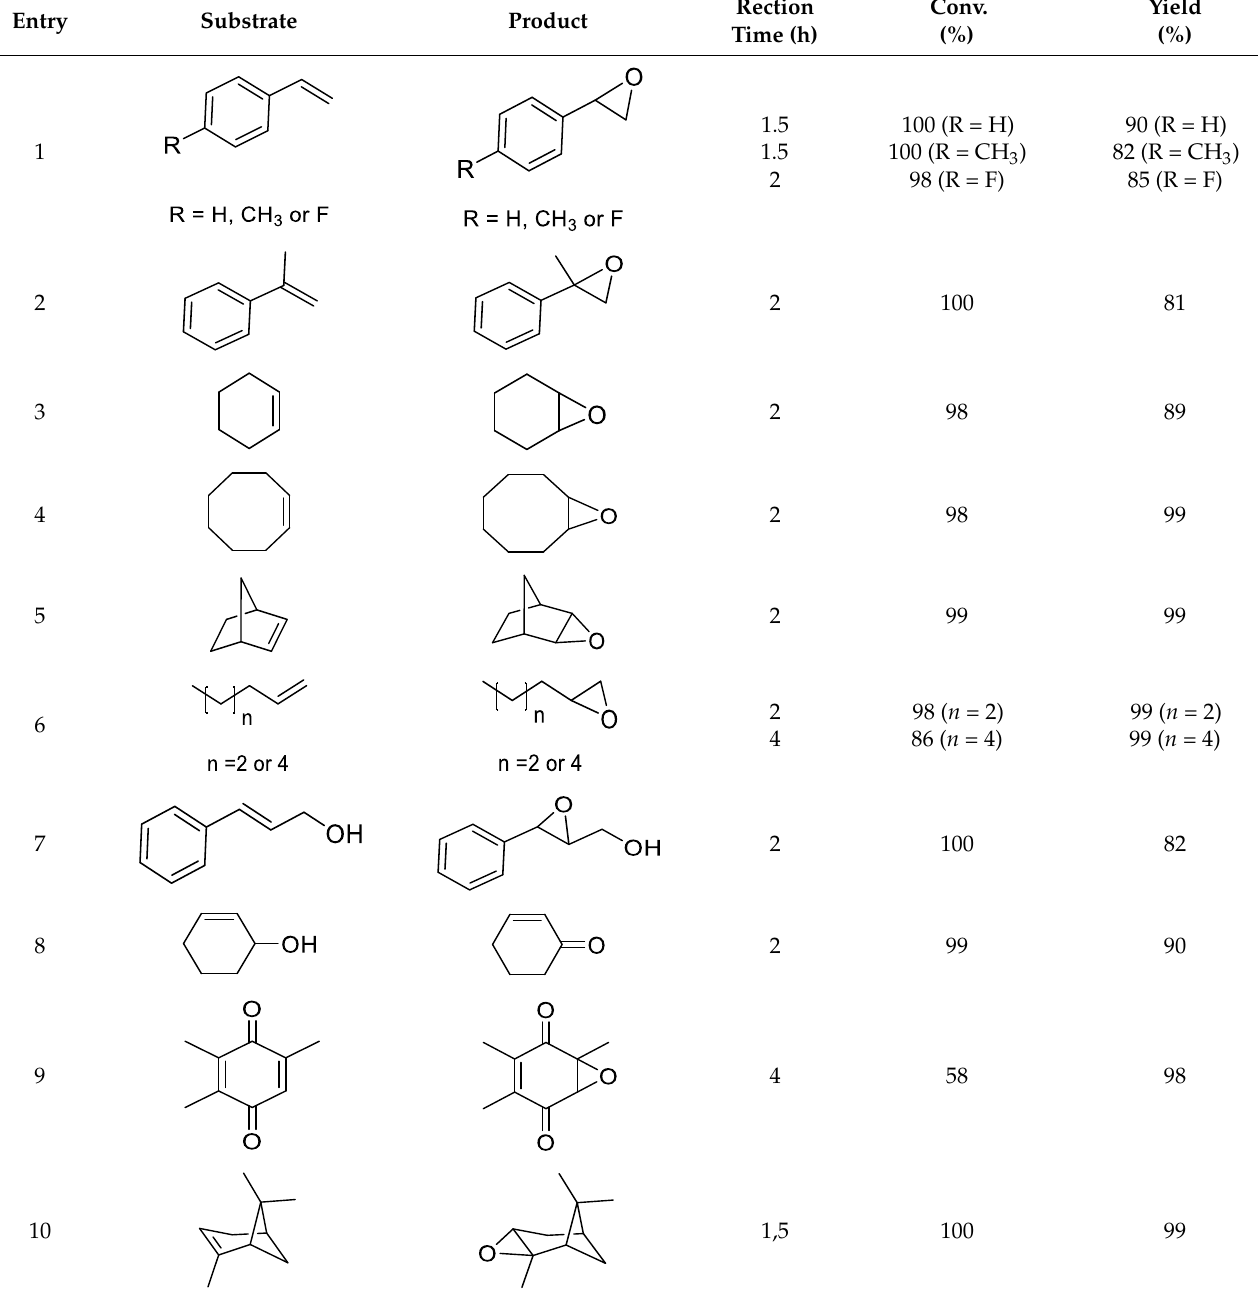
Table 5. Epoxidation of different olefins using Co(II)Pc(SO 3− ) 4 @-Zn 2 Al-LDH as catalyst [78] *. Entry Substrate